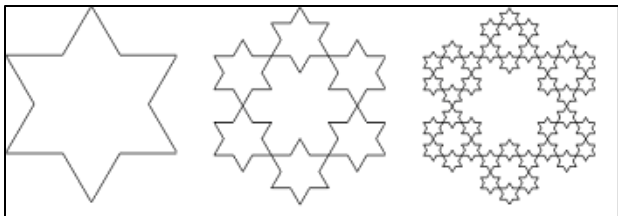
Figure 14. Construction process of the fractal auxetic cell